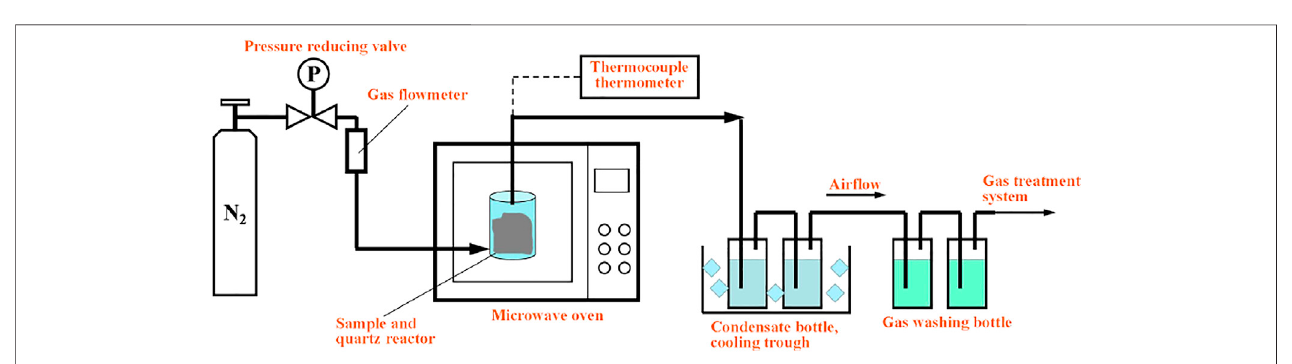
FIGURE 2 | Schematic diagram of microwave energy activation